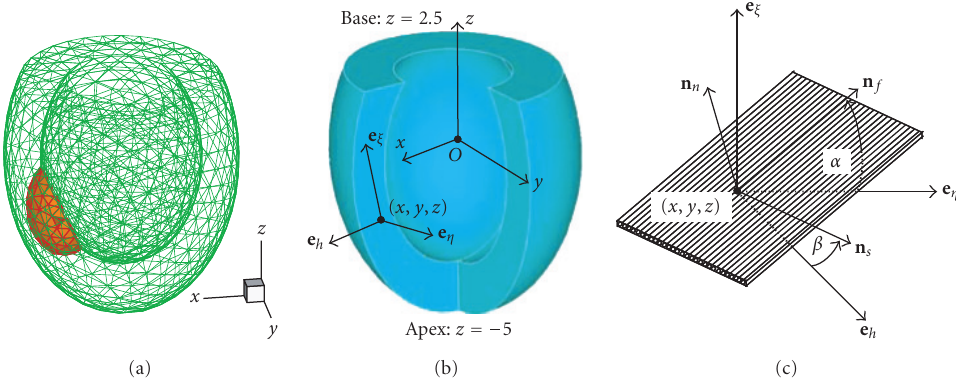
Figure 2: (a) A thick-wall hollow ellipsoidal LV phantom. Finite element mesh is shown on the surfaces. The red zone imitates an ischemic myocardial region; (b) local coordinates ( e h , e η , e ξ ) at point ( x , y , z ); (c) schematic plot of the spatial myofiber architecture described by the local material axes ( n f , n s , n n ). The myofiber direction n f lies in the ( e η , e ξ ) plane, and with a fiber angle α measured from e η . The cross-fiber direction n s is perpendicular to n f , and with a sheet angle β measured from e h . The third axis n n = n f